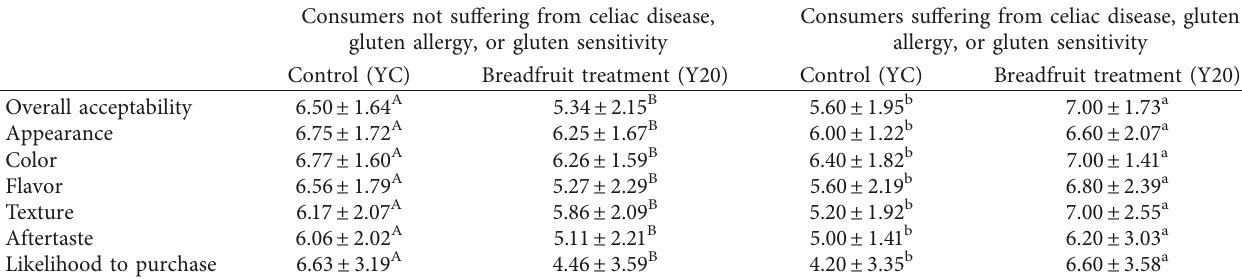
Table 7: Mean response of panelist subpopulations to sensory quality of YC and Y20 formulas. Consumers not suffering from celiac disease, Consumers suffering from celiac disease, gluten gluten allergy, or gluten sensitivity allergy, or gluten